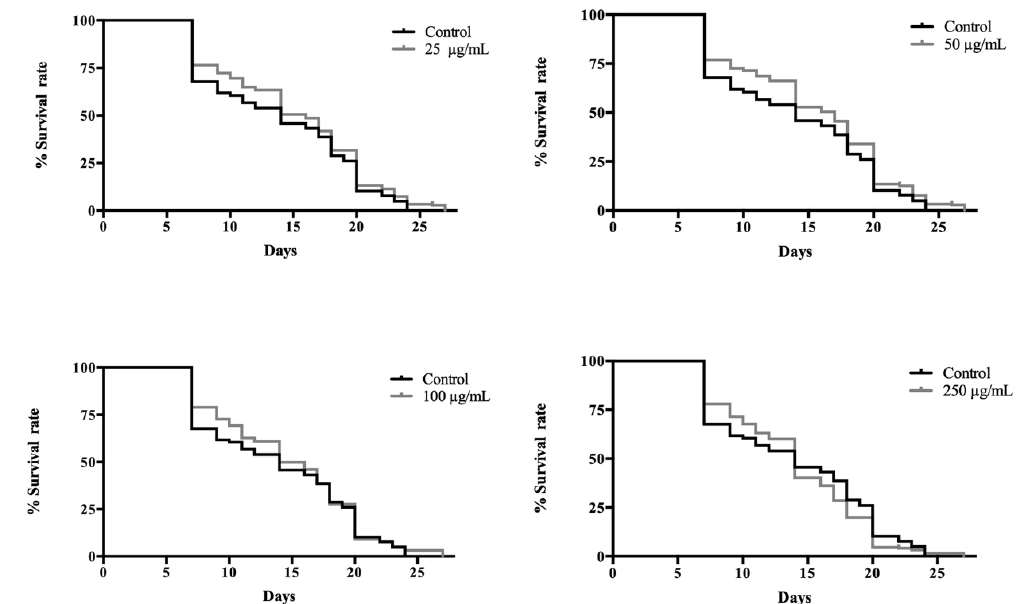
Figure 3. E ff ect of Rosmarinus o ffi cinalis flower extract on lifespan of C. elegans SS104 glp-4 (bn2) . Figure 3. Effect of Rosmarinus officinalis flower extract on lifespan of C. elegans SS104 glp-4 (bn2) . The The means of lifespan were: 14 days (control, 100 and 250 µ g / mL groups), 16 days (25 µ g / mL treated means of lifespan were: 14 days (control, 100 and 250 μ g/mL groups), 16 days (25 μ g/mL treated group) and 17 days (50 µ g / mL treated group). Results of lifespan experiments were analysed using the group) and 17 days (50 μ g/mL treated group). Results of lifespan experiments were analysed using Kaplan–Meier survival model, and for significance by means of a long rank pairwise comparison test between the control and treatment groups. Di ff erences in survival curves between the treatment and control groups were found for the concentrations of 25 ( p ≤ 0.05) and 50 ( p ≤ 0.01) µ g /